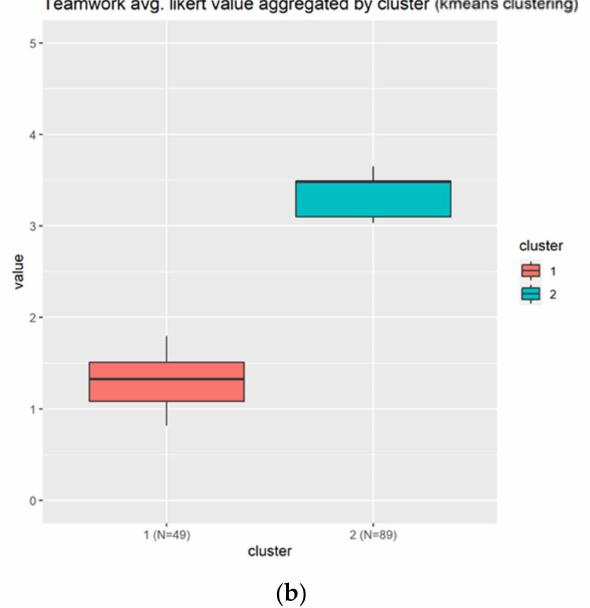
Figure 7. This figure shows the results for the teamwork. Each color identifies a different cluster. The ( a ) subplots shows the results based on each question, meanwhile the ( b ) shows the information condensed in